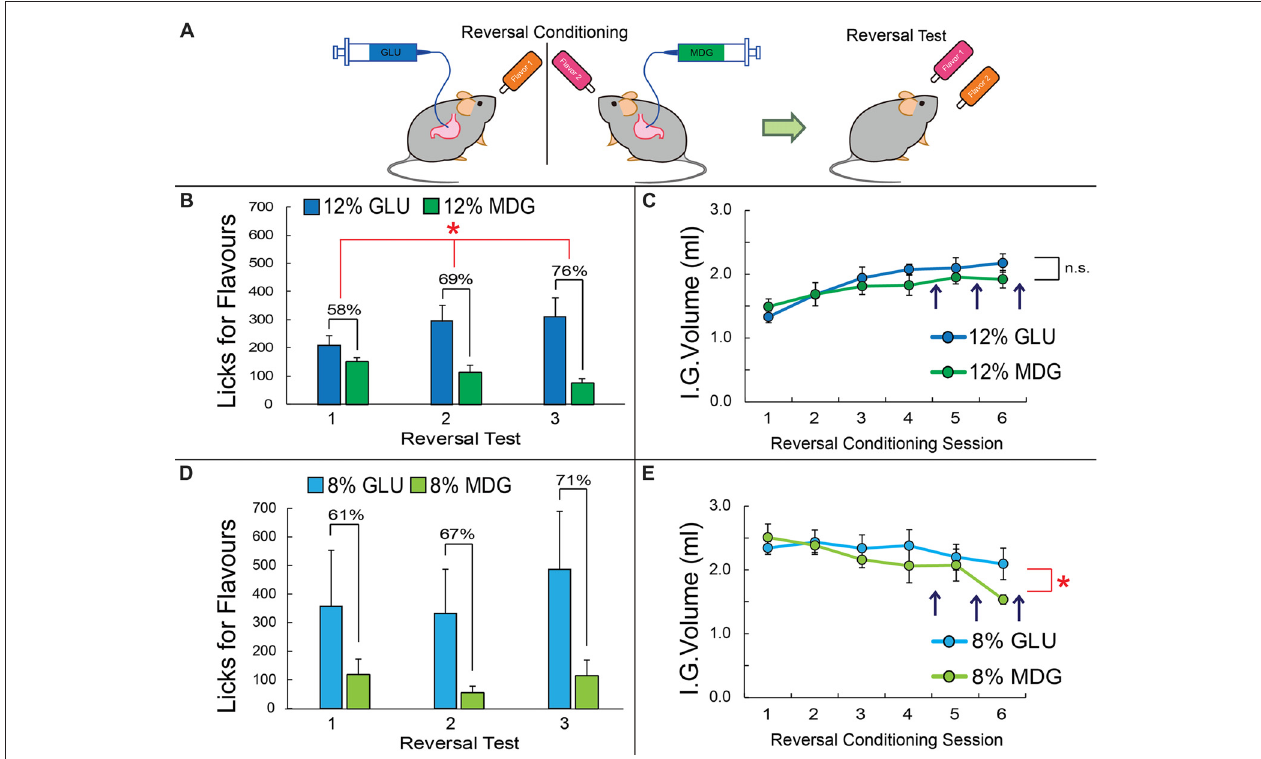
FIGURE 2 | Preferences for glucose-associated flavors are resistant to changes in contingencies. (A) After the post-conditioning test, mice previously exposed to the GLU vs. MDG conditioning (shown in Figure 1A ) were subjected to reversal learning, that is, the contingencies associating a given Flavor to one of the sugars were arbitrarily reversed (compare against Flavor colors in Figure 1A ). (B) After four sessions of reversal conditioning, preferences for the now 12% GLU-associated Flavor, i.e., for the Flavor initially associated with MDG, increased from 8% to 58%; a second preference test was performed after five reversal conditioning sessions, which yielded a preference of 69% for the newly GLU-associated Flavor. A third and final preference test was performed after six reversal conditioning sessions, yielding a preference of 78% for the newly 12% GLU-associated Flavor. (Main effect of sugar on licks for Flavors Two-way RM-ANOVA, ∗ p < 0.05). (C) Throughout reversal learning, the number of infusions for the 12% GLU vs. 12% MDG did not change significantly across time (two-way RM-ANOVA, p = 0.17). (D) After four sessions of reversal conditioning, preferences for the 8% GLU-associated flavor increased from 33% to 61%; a second preference test was performed after five reversal conditioning sessions, which yielded a preference of 67% for the newly GLU-associated flavor. A third and final preference test was performed after six reversal conditioning sessions, yielding a preference of 71% for the newly 8% GLU-associated flavor. However, no clear preferences for one flavor vs. another were observed (main effect of sugar on licks two-way RM-ANOVA, p = 0.3). (E) Throughout reversal learning, the number of infusions for the 8% GLU was significantly higher than 8% MDG with time (two-way ANOVA conditioning session × sugar, F ( 5,25 ) = 2.7, ∗ p = 0.043). Vertical dark arrows indicate when preference tests were performed. IG, Intra-Gastric infusion; ns, non-statistically significant. Data depicted as mean ± SEM, across animals in all figures.